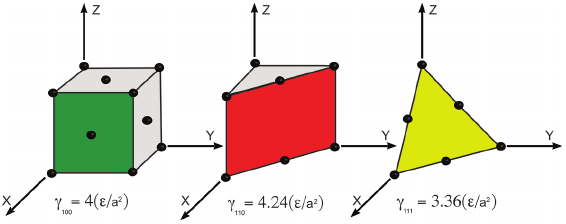
Figure 3 - Atomic arrangements and surface energy values for {100}, {110}, and {111} surface facets (from left to right, respectively).